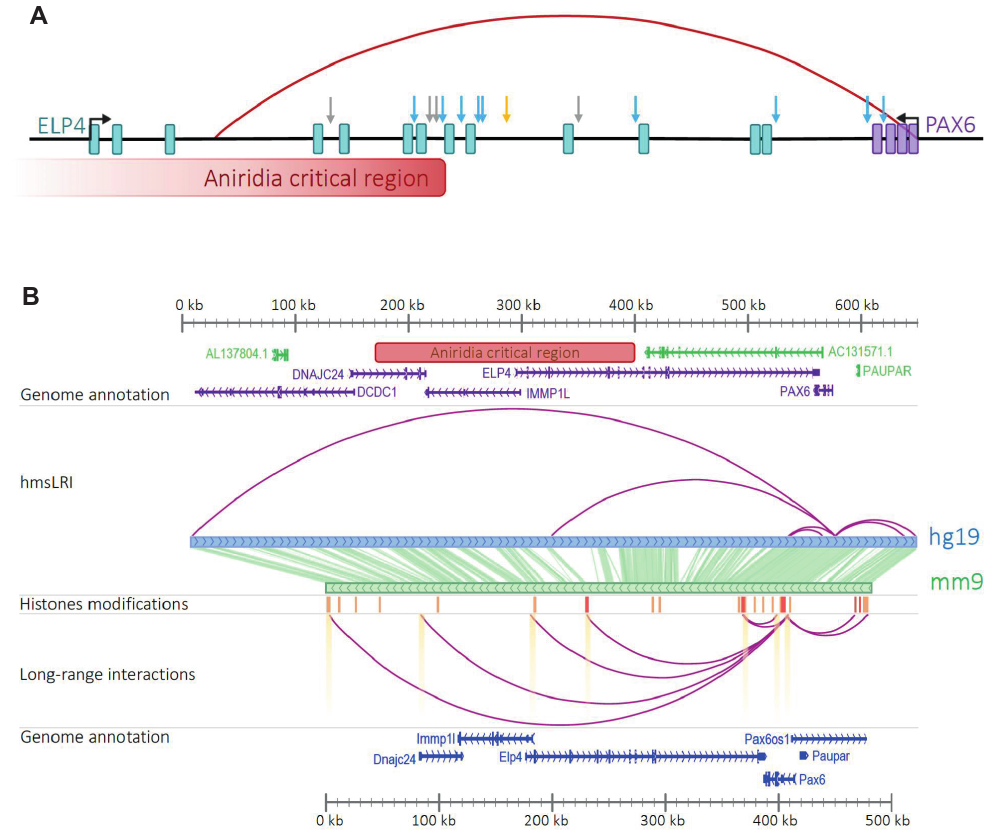
Figure 7. LRI connects PAX6 to multiple distal enhancers in the aniridia critical region. ( A ) Blue arrows represent enhancers active in ocular structures, grey ones denote enhancers active in other brain structures; in orange, the SIMO element identified by (Kleinjan et al., 2001; Kleinjan and van Heyningen 2005) [4,53]; the red arch connects PAX6 promoter to an hmsLRI-E. The aniridia critical region, chr11:31422424–31666340, encompasses our enhancer. ( B ) LRI involving the Pax6 promoter reported in (Bertolini et al., 2019) [10]; the track “histone modifications” shows regions carrying marks of poised (orange, H3K4me1) and active enhancers (red, both H3K4me1 and H3K27ac); highlighted LRI overlap with cCREs reported in (Li et al., 2021). In the upper part, long-range interactions, involving active or poised enhancers, present among our hmsLRI-E. Highlighted enhancers and promoters overlap with cCREs reported (Li et al., 2021) [11]. The middle panel is a representation of corresponding regions between the mouse (mm9) and human (hg19)